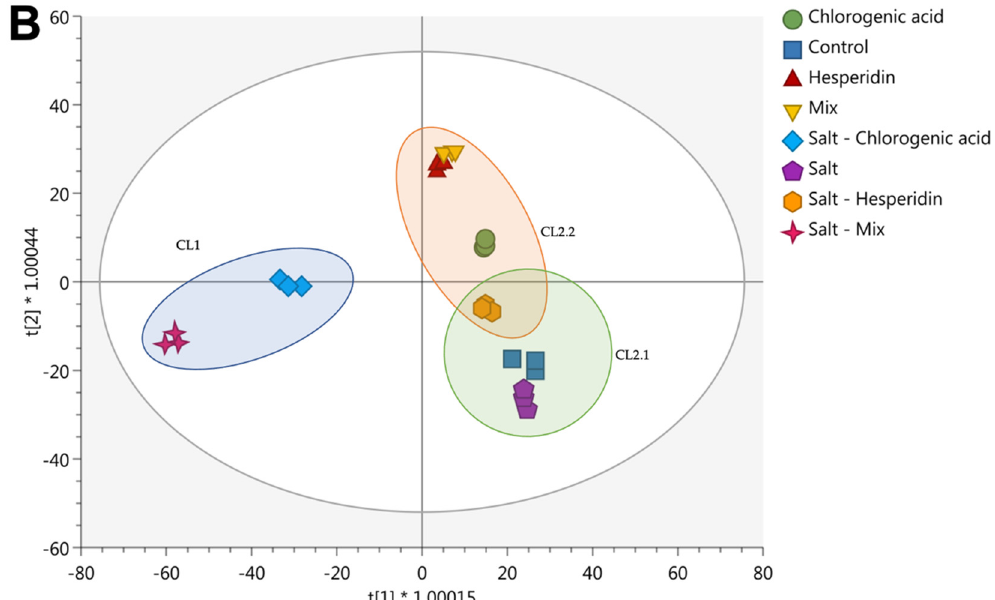
Figure 3. ( A ) Unsupervised hierarchical cluster analysis (HCA) obtained from fold-change values and ( B ) Orthogonal projection to latent structures discriminant analysis (OPLS-DA) supervised modeling of lettuce metabolome after 10 days of treatments. The lettuce vegetables were treated with: control no treated, 100 μ M hesperidin (HES), 50 μ M chlorogenic acid (CA), 100 μ M HES + 50 μ M CA (Mix). Treatments were performed both under salt (40 mM NaCl) and no-salt (0 mM NaCl) stress. *: mathematical multiplication.